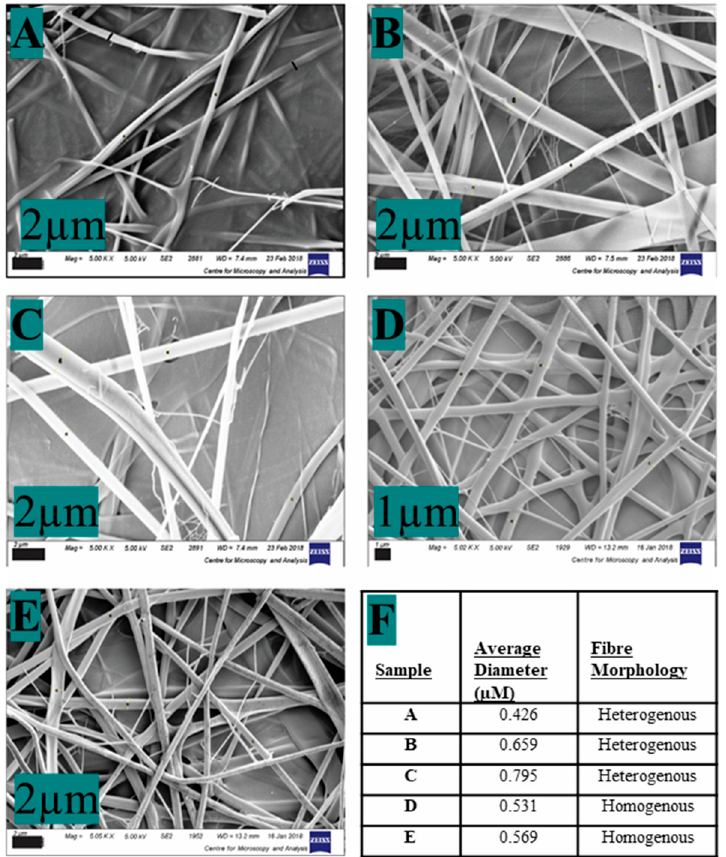
Figure 1. SEM images under 5K magnification for samples ( A ): mean fibre diameter ± standard deviation ( μ M) = 0.426 ± 0.115 ( B ): mean fibre diameter ± standard deviation (SD) ( μ M) = 0.659 ± 0.437 ( C ): mean fibre diameter ± SD ( µ M) = 0.795 ± 0.416 ( D ): mean fibre diam- eter ± SD ( µ M) = 0.531 ± 0.205 ( E ): mean fibre diameter ± SD ( µ M) = 0.569 ± 0.219, n = 30 and ( F ) summary of average diameter and morphology of each